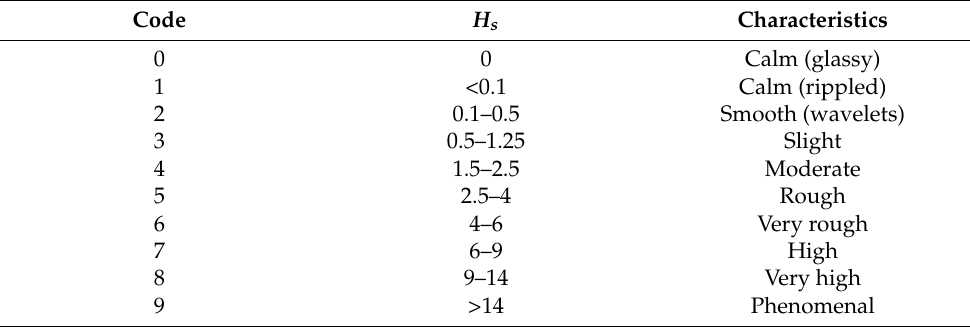
Table 2. Sea States Codes based on Douglas Sea